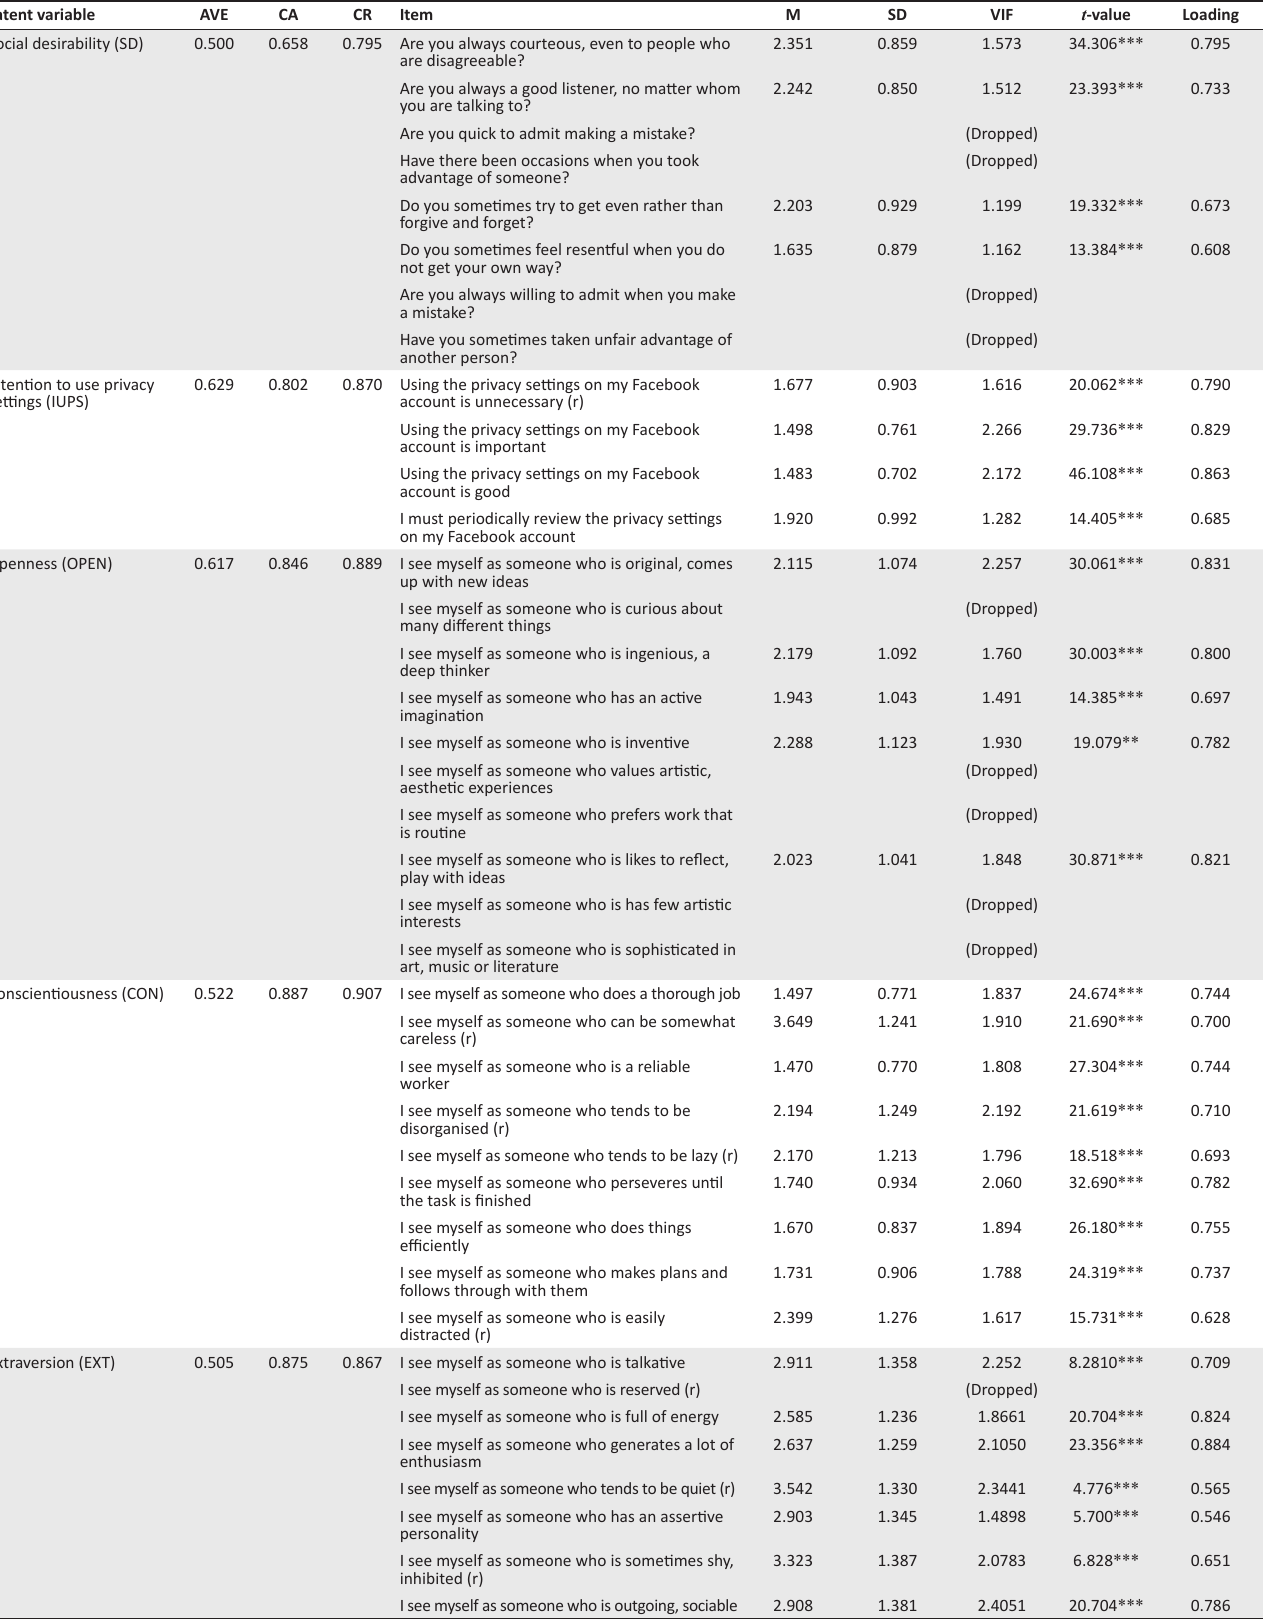
TABLE 1-A1: Descriptive statistics of questionnaire items ( r = reverse